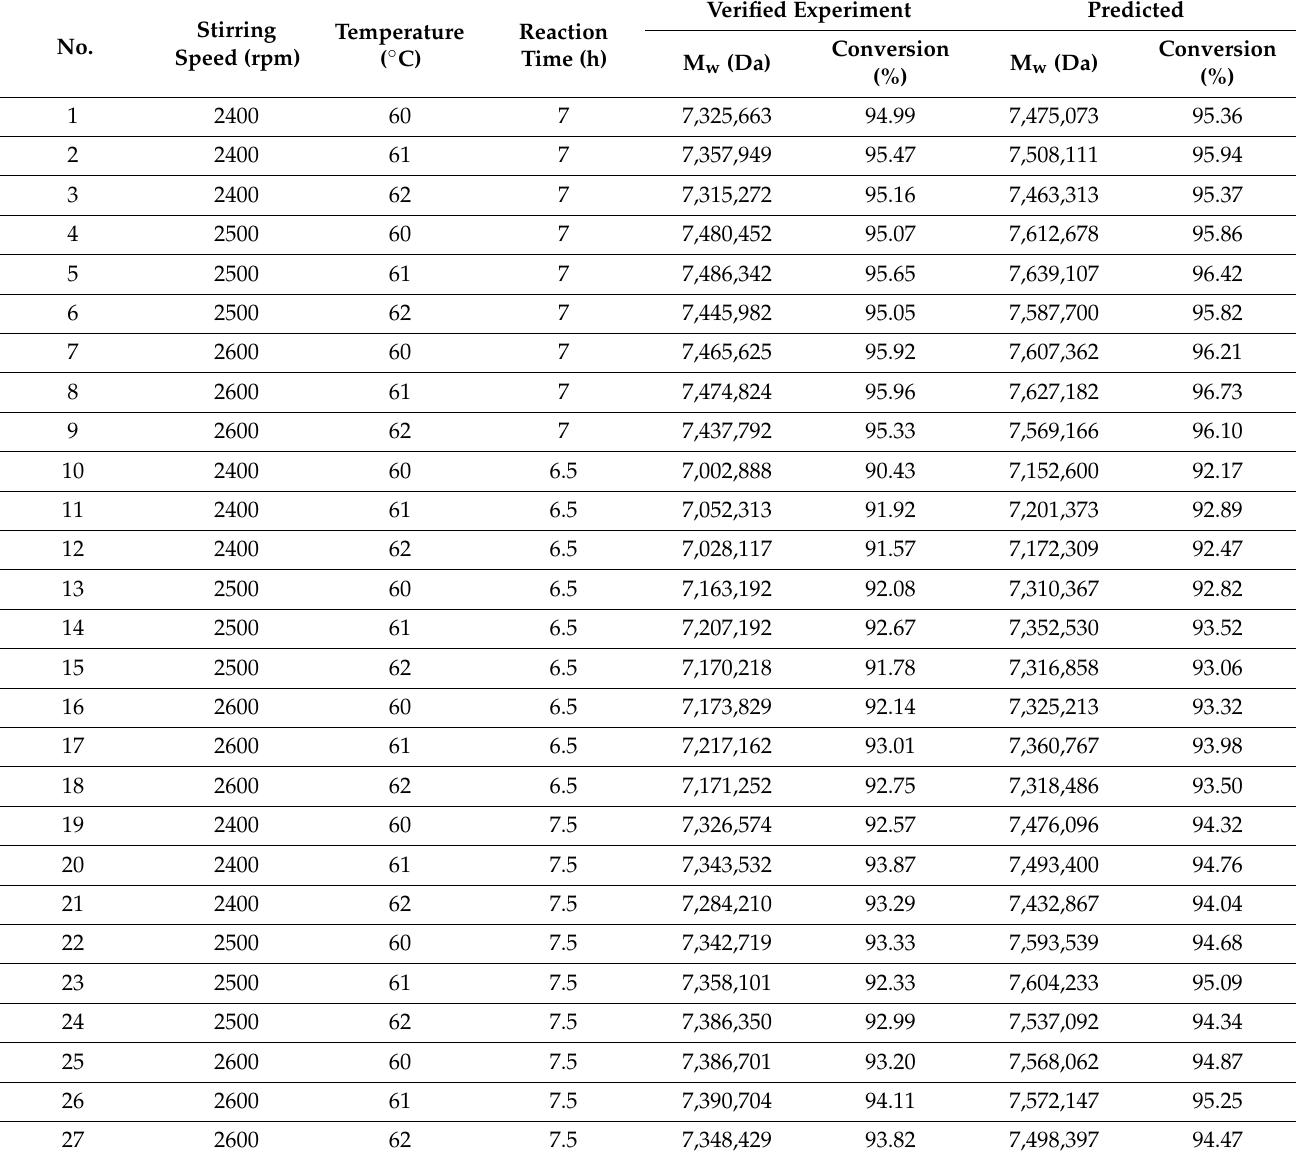
Table 6. Molecular weight and conversion of CPAM according to verified